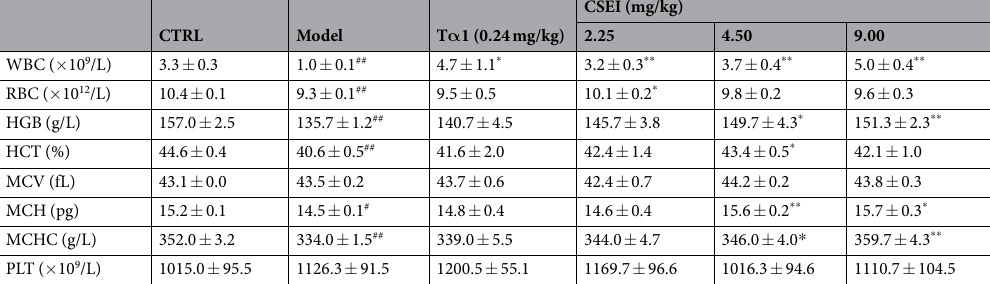
Table 2. Effects of CSEI on peripheral blood cells of CTX-injected mice with hematopoietic injury. 100 mg/kg of CTX was intraperitoneally injected to mice except controls for three days. Then T α 1 and CSEI were treated for another 21 days. At the end of the experiment, peripheral blood of mice were collected and analyzed via a blood cell analyzer. Data are showed as the means ± S.E.M. (n = 10). # P < 0.05 and ## P < 0.01 versus CTRL group, * P < 0.05 and ** P < 0.01 versus model